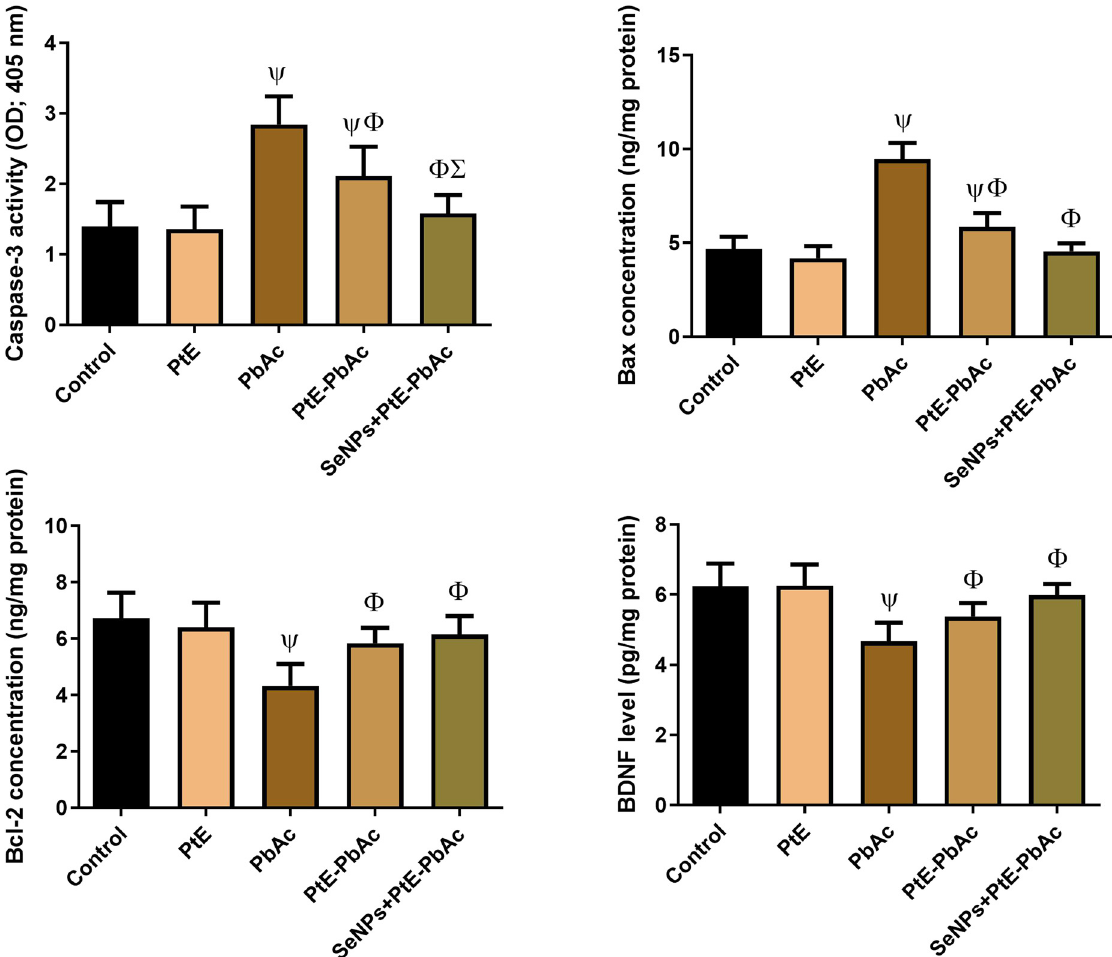
Figure 6: E ff ects of orally administered PtE or PtE - SeNPs on the levels of neural apoptotic markers ( Bax, Cas - 3, Bcl - 2, and BDNF ) in the brain of PbAc - injected rats. ψ , Φ , Σ superscript letters indicate statistical signi fi cance at P < 0.05 against control, PbAc, and PtE - PbAc group, respectively. All results are presented as the mean +